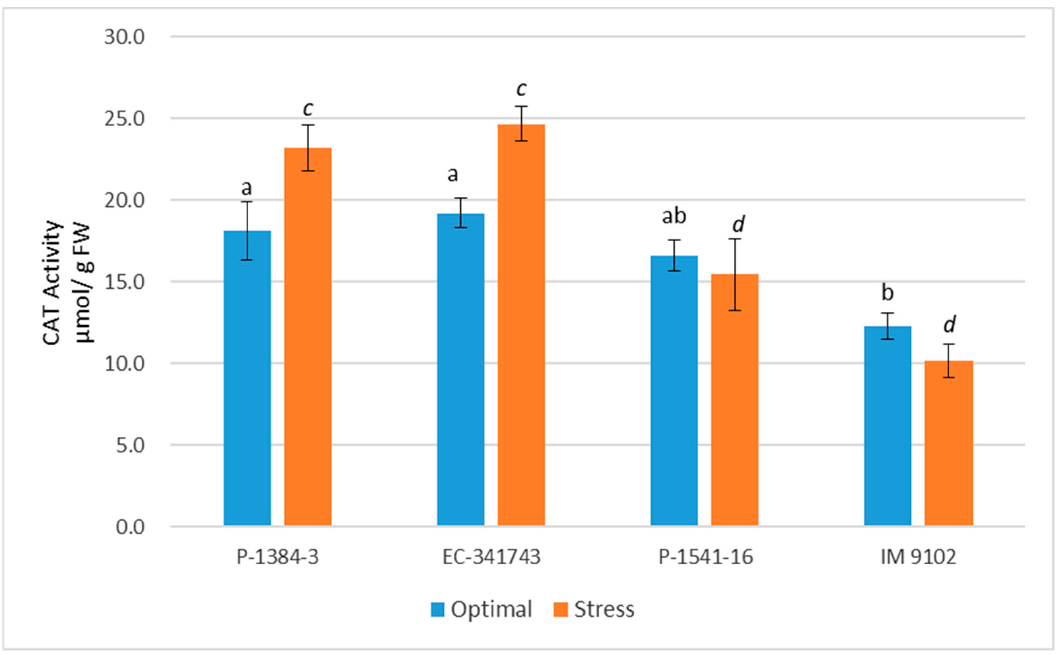
Figure 8. Catalase enzyme activity of four field pea genotypes under optimal and heat stress. Columns with different letters indicate significant difference at p ≤ 0.05 (Fisher LSD test).